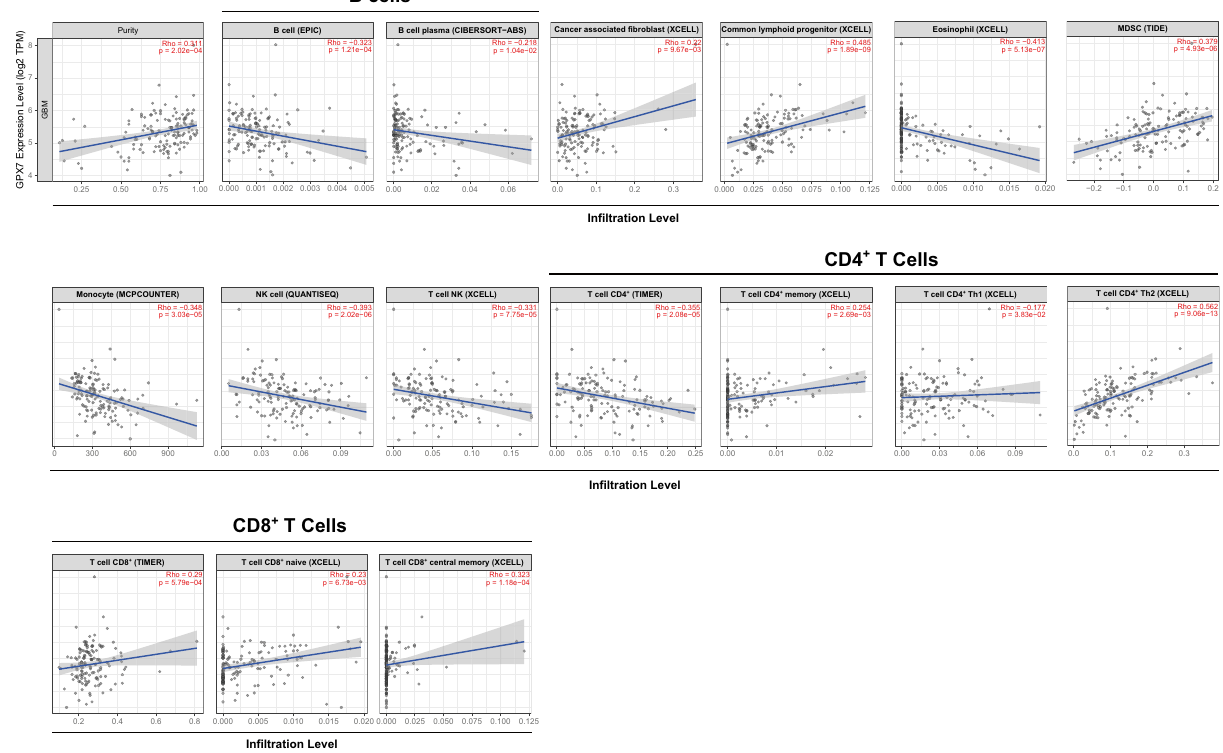
Figure 11. Correlation of GPX7 expression with immune infiltration level in GBM (TCGA dataset) via Tumor Immune Estimation Resource (TIMER) database. All spearman correlations were adjusted for tumor